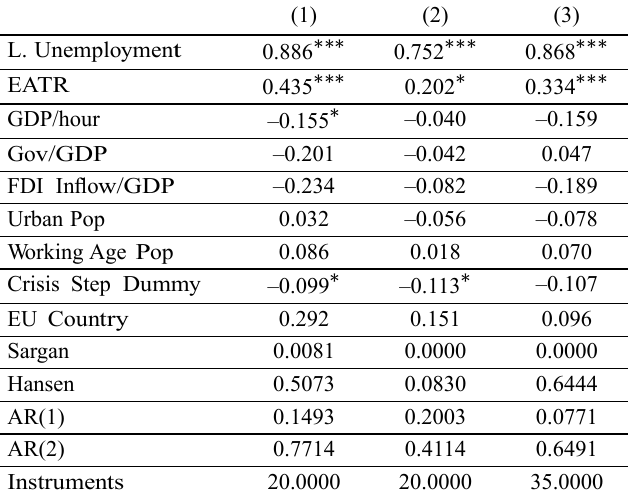
Table 4. Estimation results with differing lagged